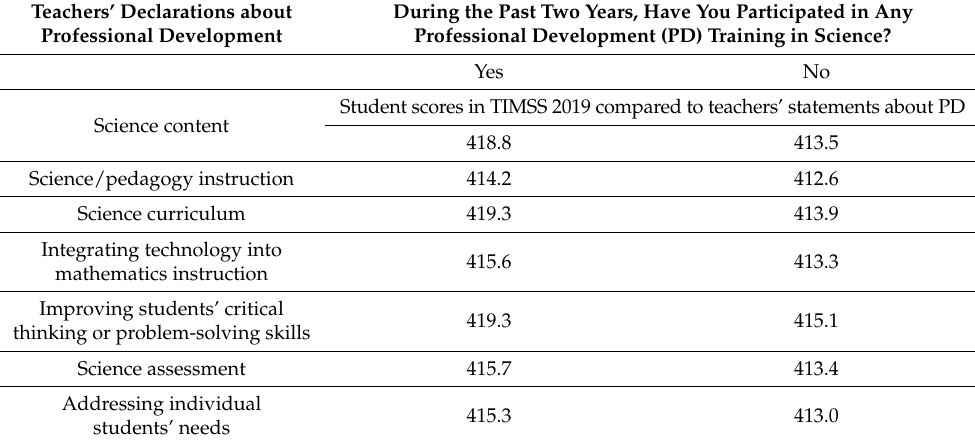
Table 6. The professional development of teachers compared with the average scores of students in